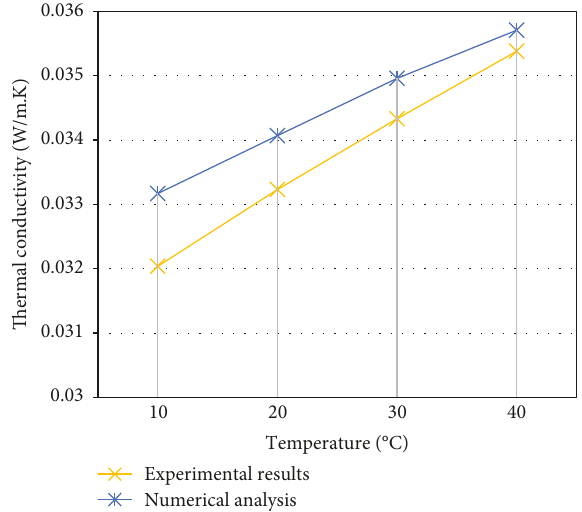
Figure 9: The comparison of the experimental and numerical results for the expanded polystyrene with the density value of 21kg/m 3